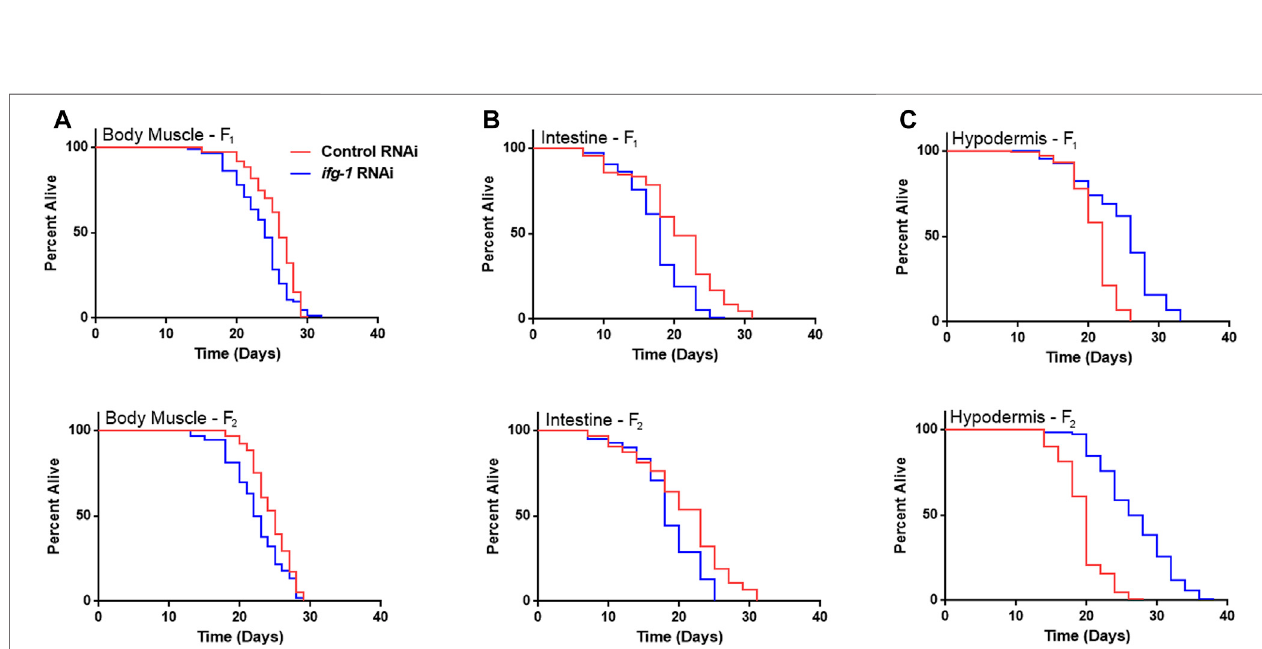
FIGURE 3 | Developmental and multi-generational knockdown of ifg-1 in body muscle or intestine decreases lifespan. Low translation in F1 (top panel) and F2 (bottompanel)generationsbycontinuousexposuretobacteriabearingdsRNAof ifg-1 orcontrolwascarriedoutintissue-speci fi cRNAistrains. (A) Medianlifespaninthe WM118bodymuscle-speci fi cRNAistraindecreasedby7.7%intheF1generation( p (cid:1) 0.0013)andby8.0%intheF2generation( p < 0.0001). (B) Medianlifespan inthe VP303 intestine-speci fi c RNAi strain decreased by 10.0% in the F1 generation ( p < 0.0001) and by 21.7% in the F2 generation ( p (cid:1) 0.0002). (C) Median lifespan in theNR222hypodermis-speci fi cRNAistrainincreasedby18.2%intheF1generation( p < 0.0001)andby35.0%fortheF2generation( p < 0.0001).Kaplan – Meiersurvival curves were compared using the Mantel – Cox log-rank test. See Supplementary Table S4 for additional details and replicates.